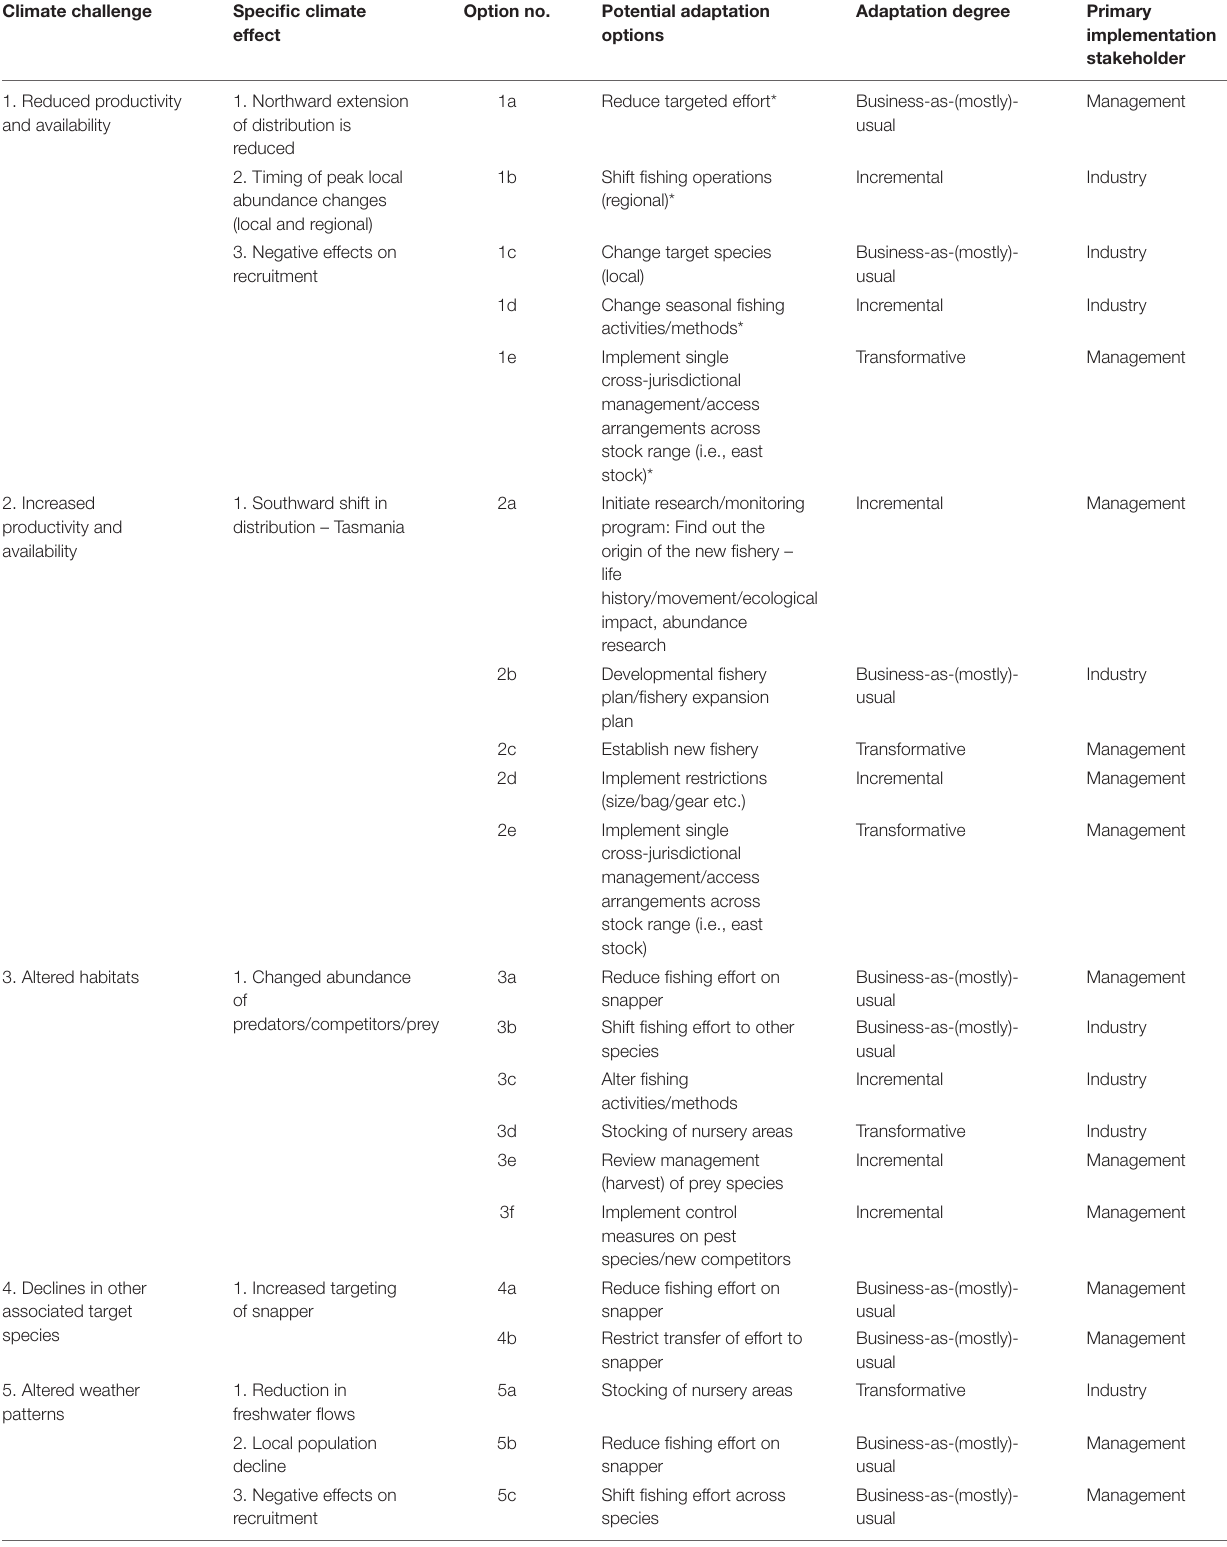
TABLE 3C | Summary characterization of adaptation options identified for